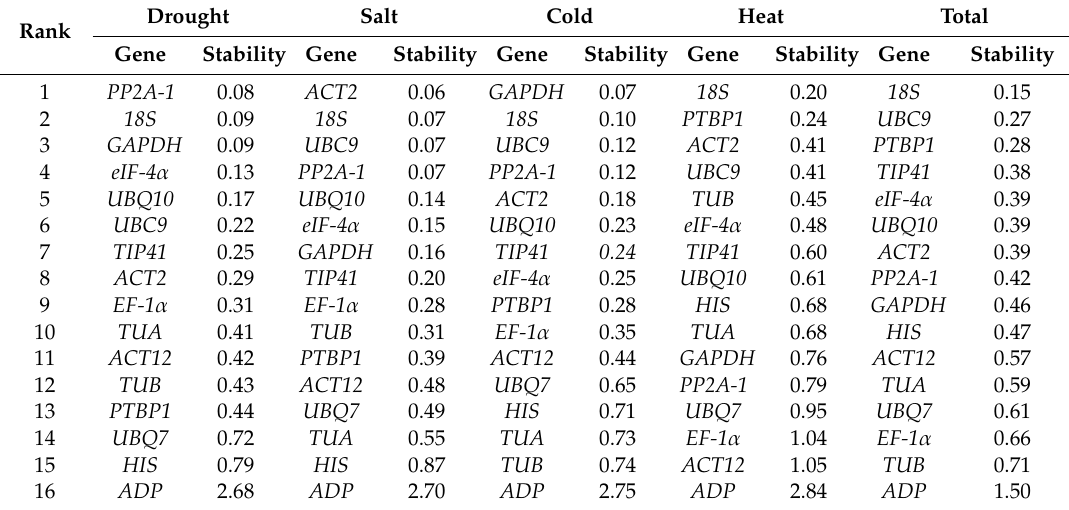
Table 4. Gene expression stability in L. olgensis . under multiple stress treatments, as ranked by the software program NormFinder.